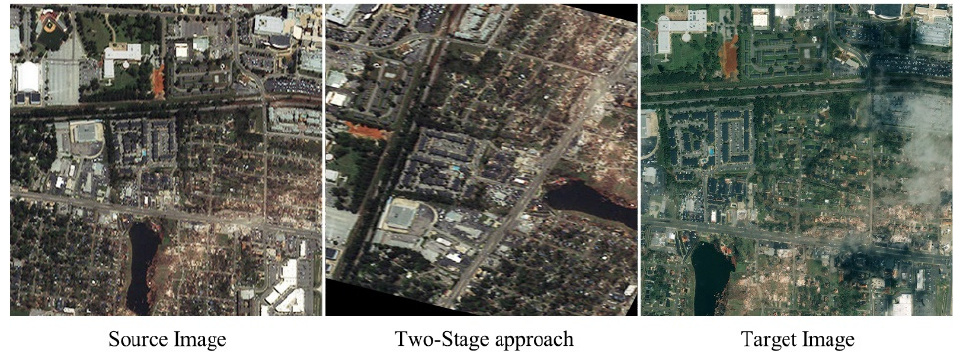
Figure 19. The failure case on the images with large resolution variance. The original resolution of